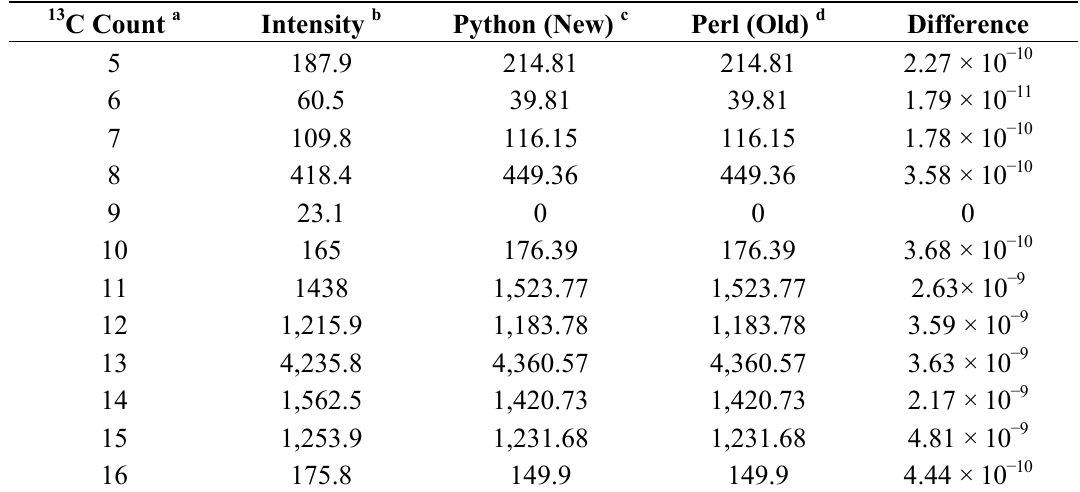
Table 1. Comparison of the old Perl and new Python single-isotope algorithm implementations using isotopologues of